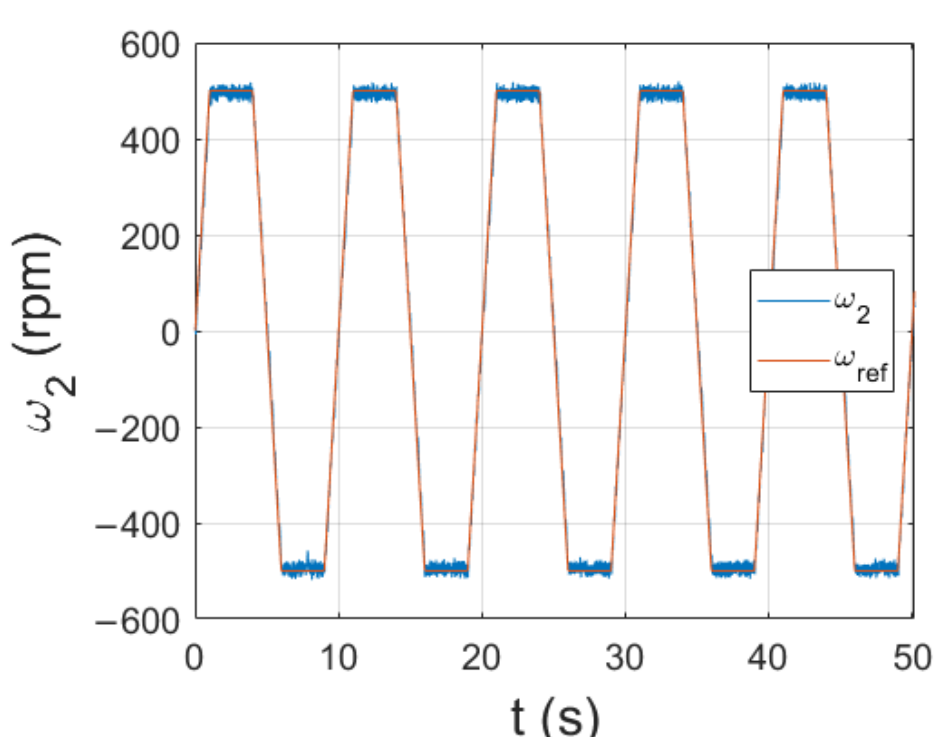
Figure 16. Rotational speed of the load machine achieved with the proposed control structure— experimental